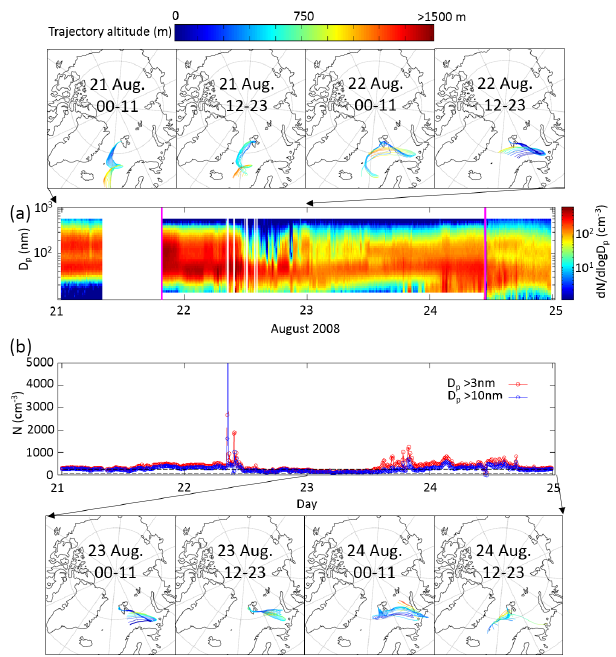
Figure 4. (a) Particle number size concentration measured before, during and after the size-resolved CCN concentration measure- ments were conducted in August 2008. Purple vertical lines indicate the start and end time of the CCN size-resolved concentration mea- surements. (b) Time series of the 8min medians from CPC mea- surements for the same period in August 2008. Horizontal dashed lines represent the 25th and 75th percentile of the CN number con- centration for August during the years 2001 to 2010. Trajectory plots show 5-day backward trajectories, calculated for every hour. Trajectory plots on top of panel (a) show air masses arriving be- tween the 21 and 23 August 2008 at the Zeppelin research station. Trajectory plots below panel (b) show air masses arriving between midnight of the 23 August to midnight of the 24 August at the Zep- pelin research